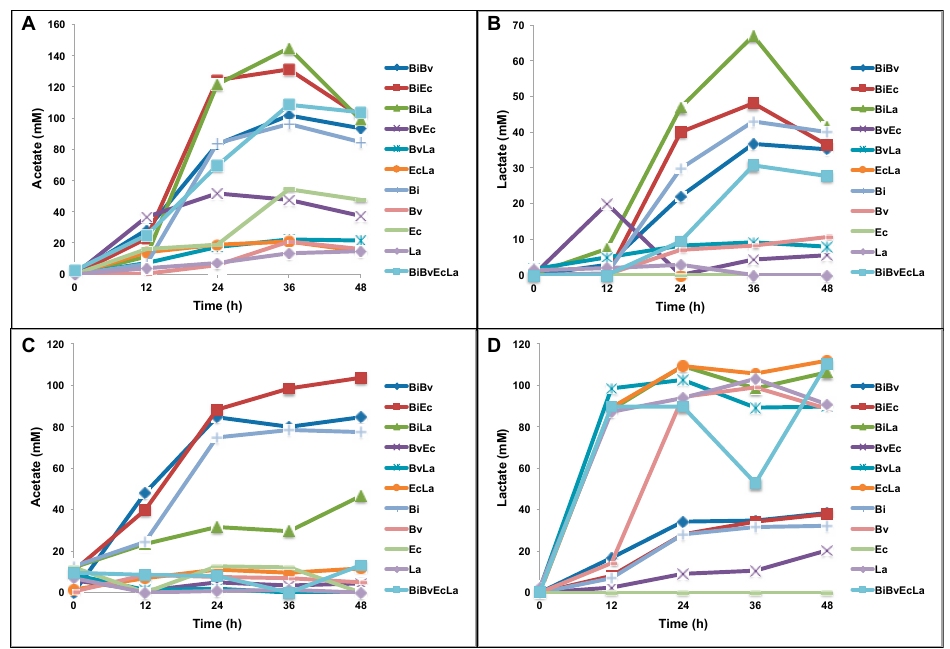
Figure 6. Acetate and lactate production during growth in 2FL ( A , B ) or FOS ( C , D ). Data was obtained for mono and co-cultures of Bi ( Bi. infantis ), Bv ( Ba. vulgatus ), Ec ( E. coli ) and La ( L. acidophilus ). The acids were quantified from bacterial supernatants every 12 h of incubation and expressed in mM.